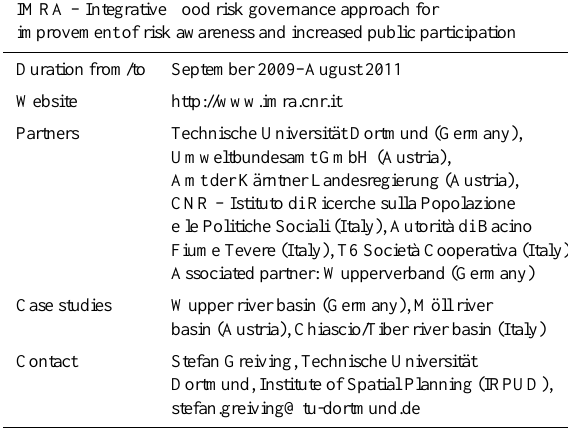
Table A5. Details of the IMRA